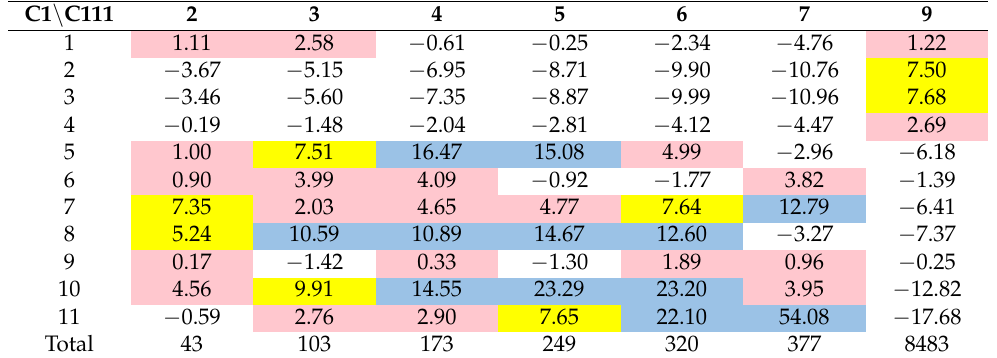
Table A1. Theoretical frequencies CUF 2018 (C1 \ C111). Land cover categories with distinctive concentrations are shaded blue, those with significant concentrations are shaded yellow, and those with minor concentrations are shaded pink.